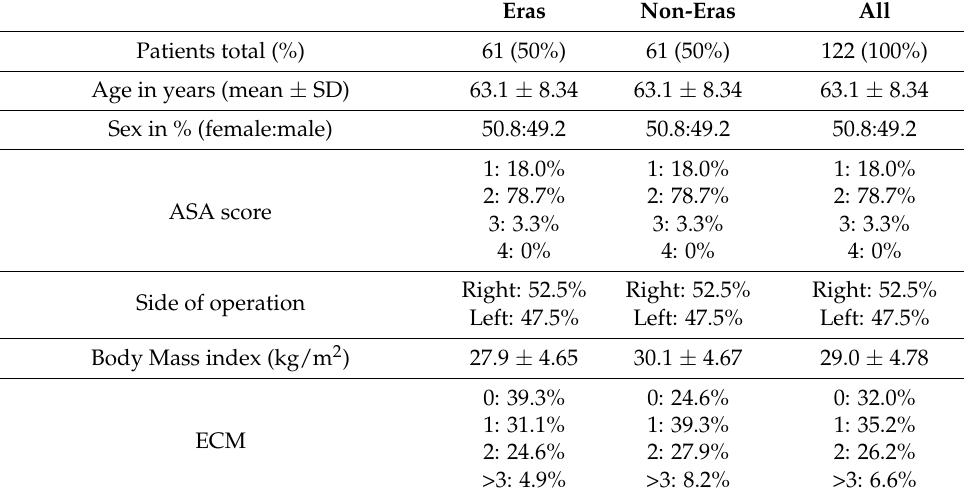
Table 2. Demographic and general data after